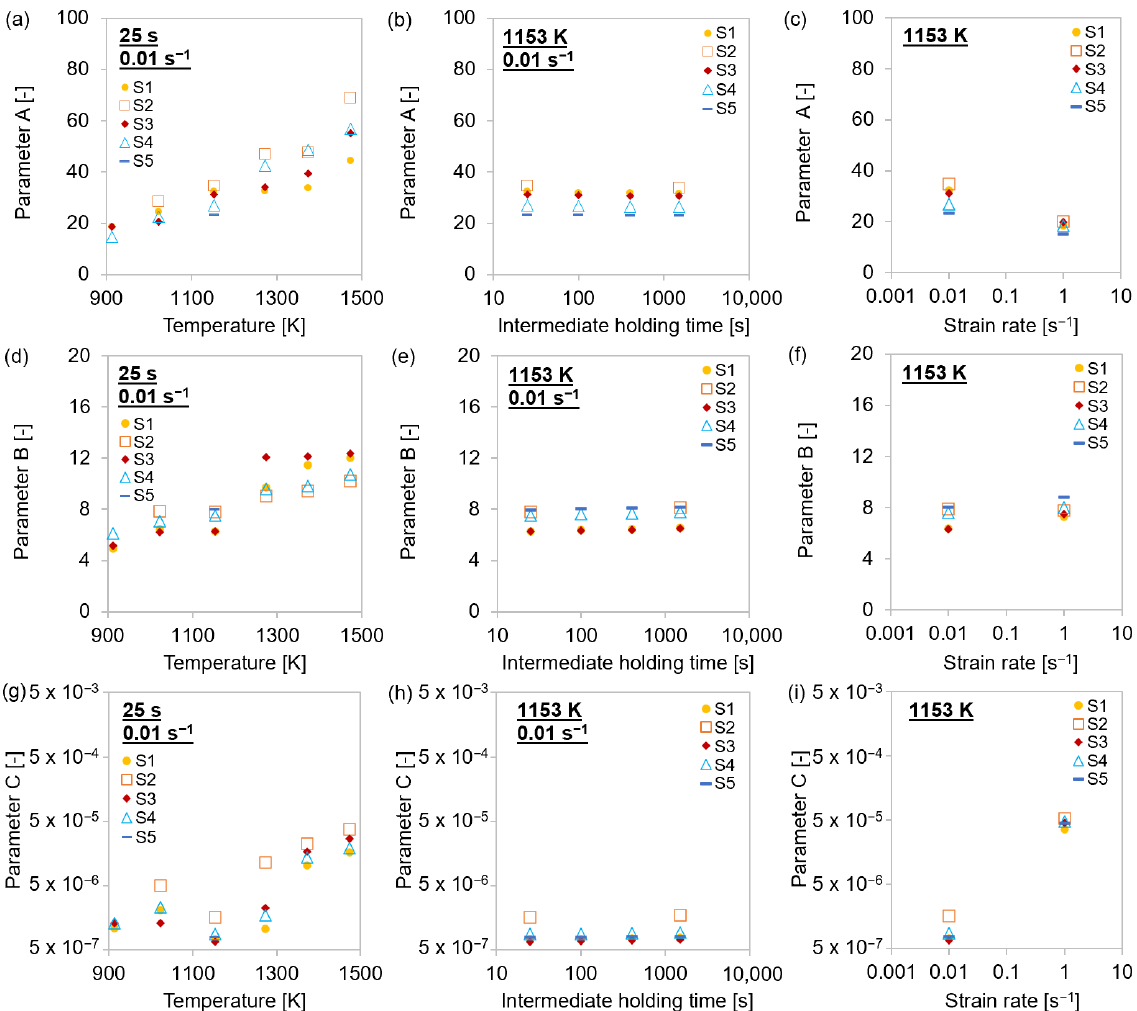
Figure 10. Strengthening parameters for single-hit compression tests with 25–1500 s holding times before deformation and 0.01–1 s − 1 strain rates at 913–1473 K for MA steel grades S1–S5. ( a – c ) Parameter A; ( d – f ) parameter B; ( g – i ) parameter C .